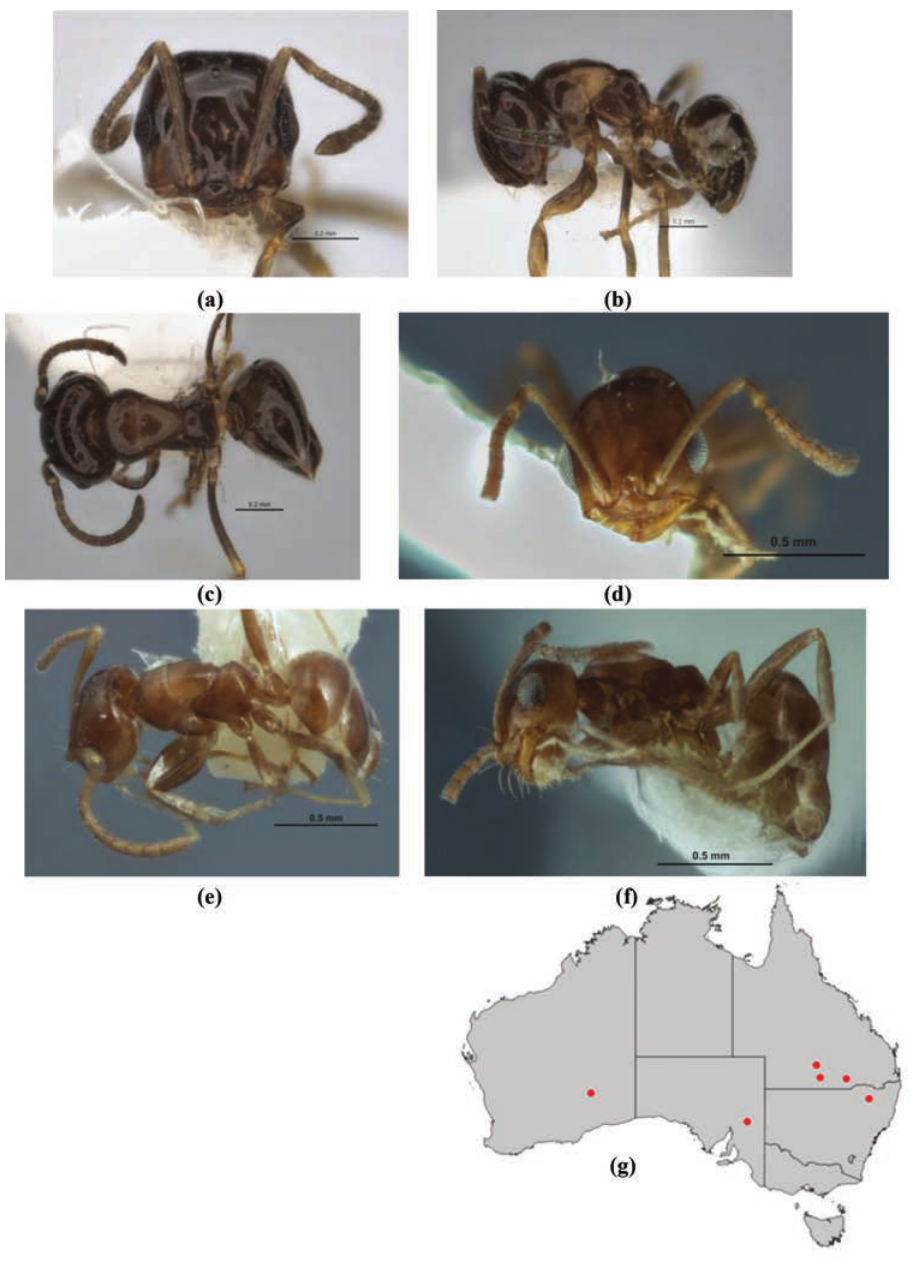
Figure 43. Melophorus minimus sp. n.: major worker paratype (JDM32- 005036–top ant) frons ( a ), pro- file ( b ) and dorsum ( c ); minor worker holotype (ANIC32-900133–bottom ant) frons ( d ), profile ( e ) and dorsum ( f ); distribution map for the species ( g ). Low resolution scale bars: 0.5 mm ( d–f ); 0.2 mm ( a–c